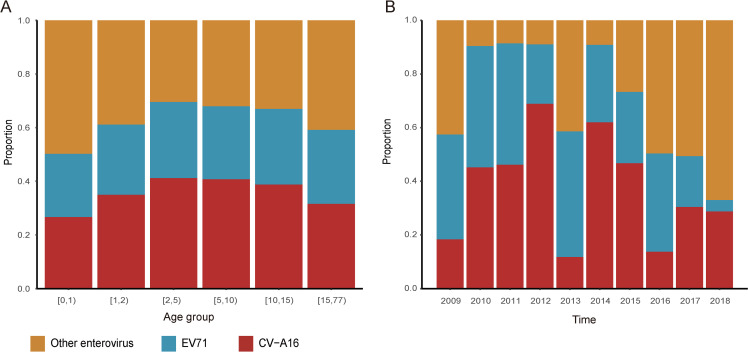
Virus etiology of hand foot and mouth disease in Xinjiang Uighur Autonomous Region during 2009–2018.(A) The distribution of virus subtype by age group. (B) The distribution of virus subtype by year.